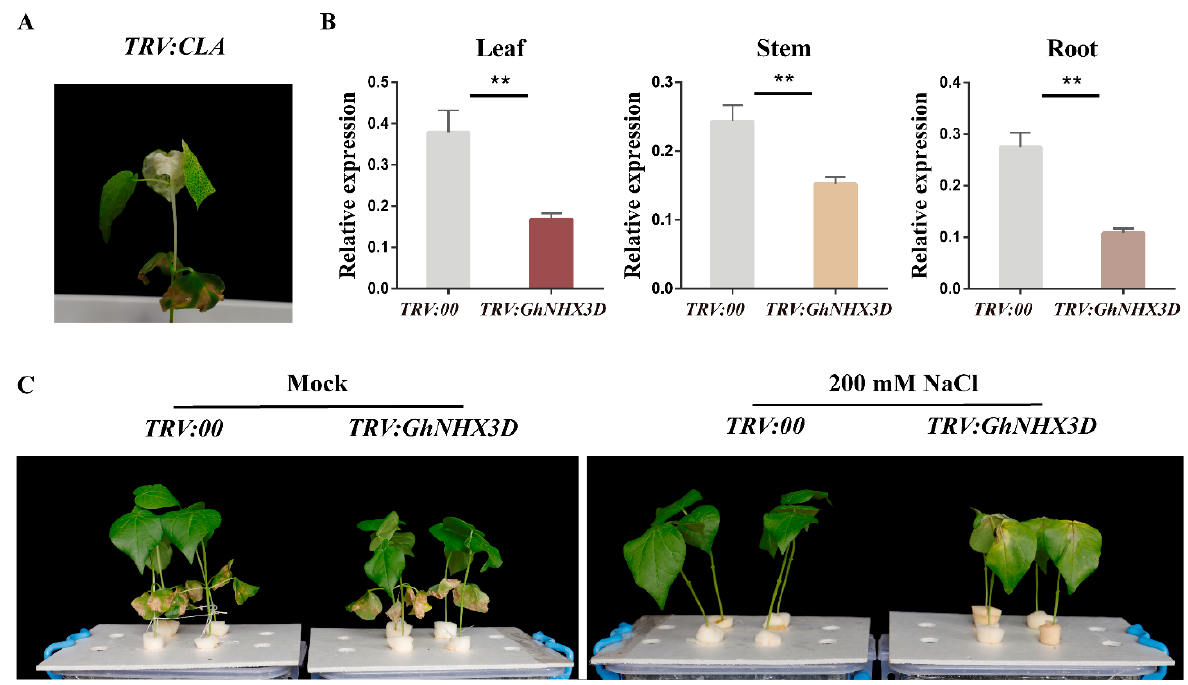
Figure 5. Silencing of GhNHX3D in upland cotton. ( A ) TRV:CLA is an albino phenotype used as a positive control. ( B ) GhNHX3D transcript levels in TRV:00 and TRV: GhNHX3D . GhHIS3 was used as an internal control. Data are means ± standard deviation of three biological replicates. Significant differences between groups (Student’s t -test): **, p < 0.01. ( C ) Phenotypes of TRV:00 and TRV:GhNHX3D under mock and 200 mM NaCl treatment for 10 days.